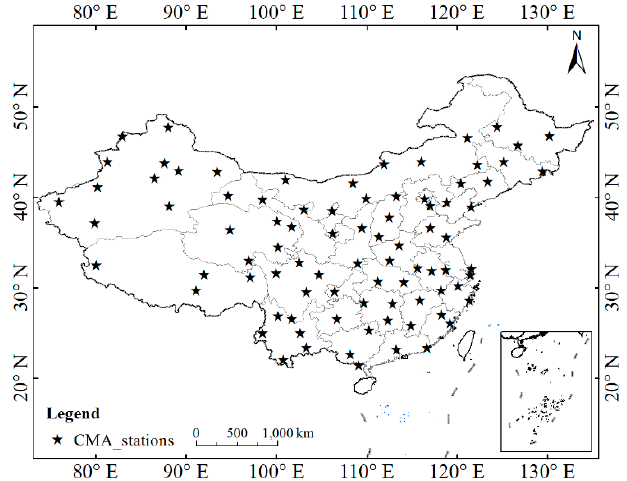
Figure1. Spatialdistributionofthe86ClimateDataCenteroftheChineseMeteorologicalAdministration Figure 1. Spatial distribution of the 86 Climate Data Center of the Chinese Meteorological (CDC / CMA) radiation Administration (CDC/CMA) radiation stations.